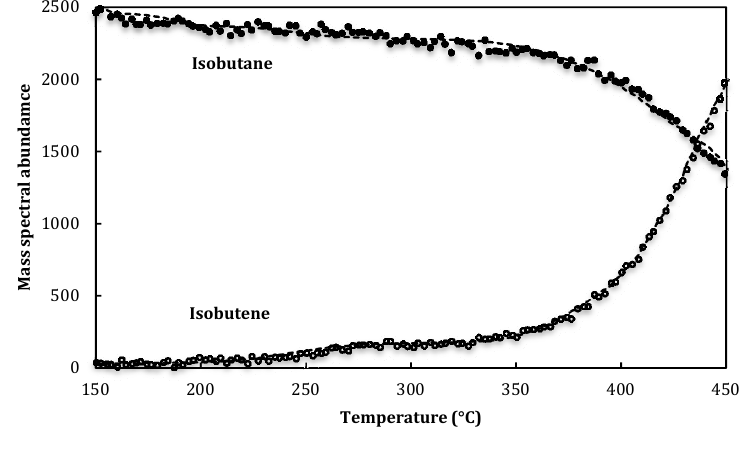
Figure 4. Raw mass spectral abundances (black circles) and wavelet denoised abundances (dashed line) for isobutane and isobutene plotted against temperature for the first temperature-programmed run over HZSM-5.